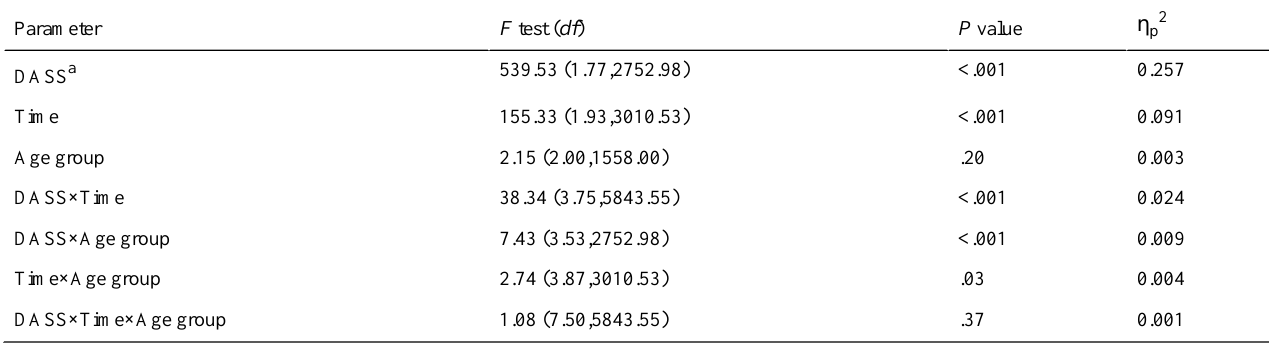
Table 5. Repeated measures effects of DASS across time, by age